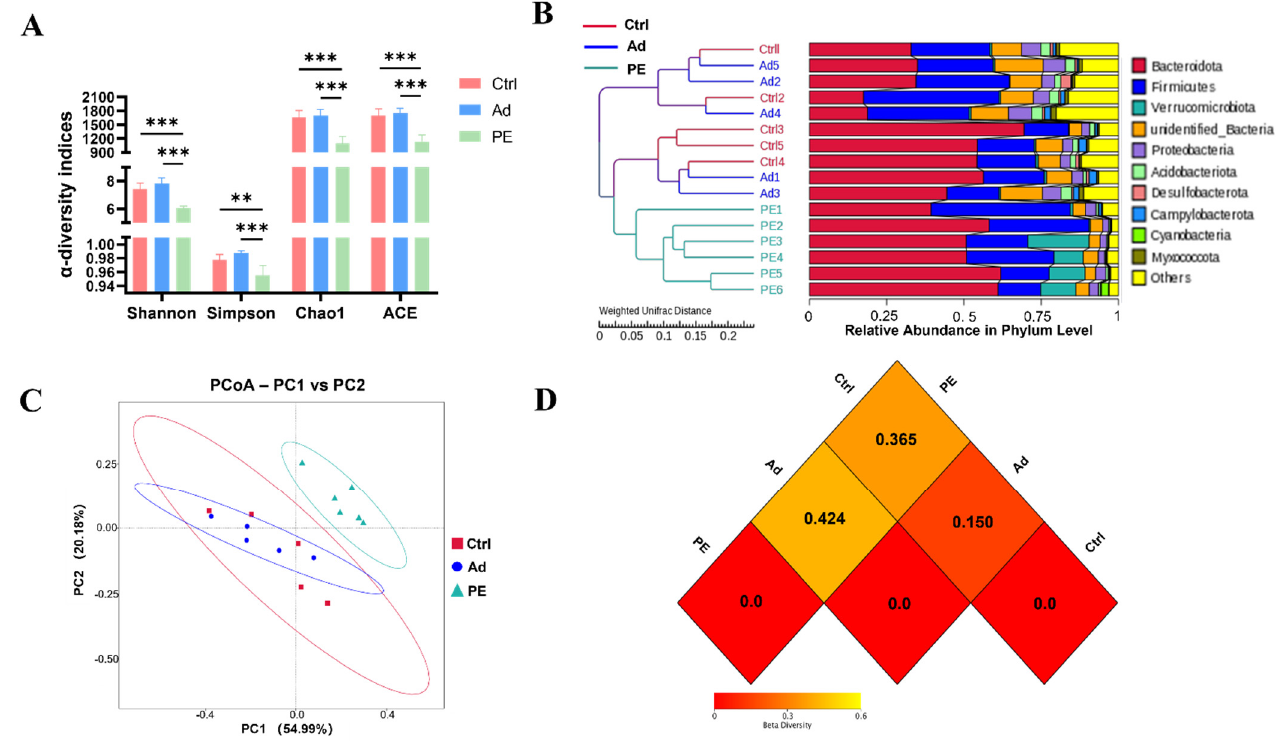
Figure 5. The diversity of colonic gut microbiota in mice ( n = 6 for PE group; n = 5 for Ad and Ctrl groups). ( A ) α − diversity indices were assessed by Shannon, Simpson, Chao1, and ACE. β − diversity indices were assessed by the cluster tree at the phylum level ( B ), PCoA analysis ( C ), and heatmap ( D ) based on weighted UniFrac distances. Each dot represented one sample. ns: no significance; **: p < 0.01; ***: p < 0.001.